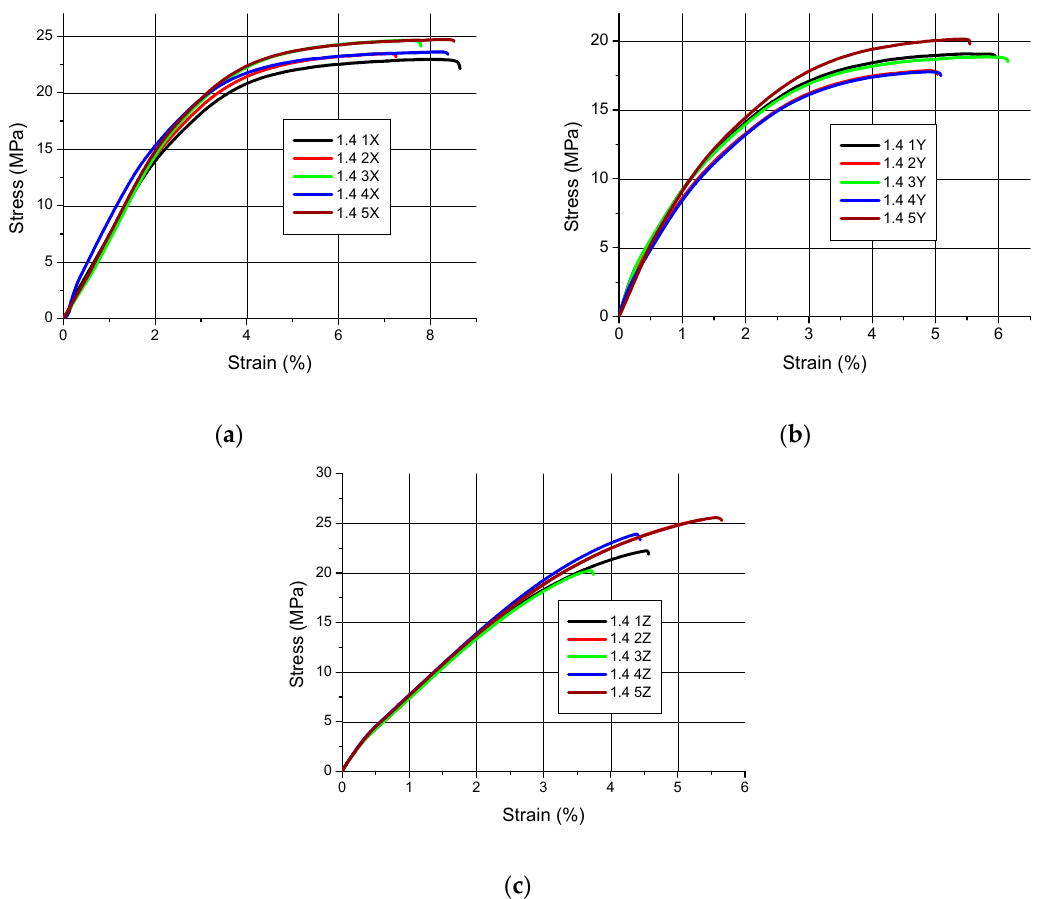
Figure 3. Tensile curves for samples with a nominal thickness of 1.4 mm ( a ) orientation X, ( b ) orientation Y, ( c ) orientation Z.